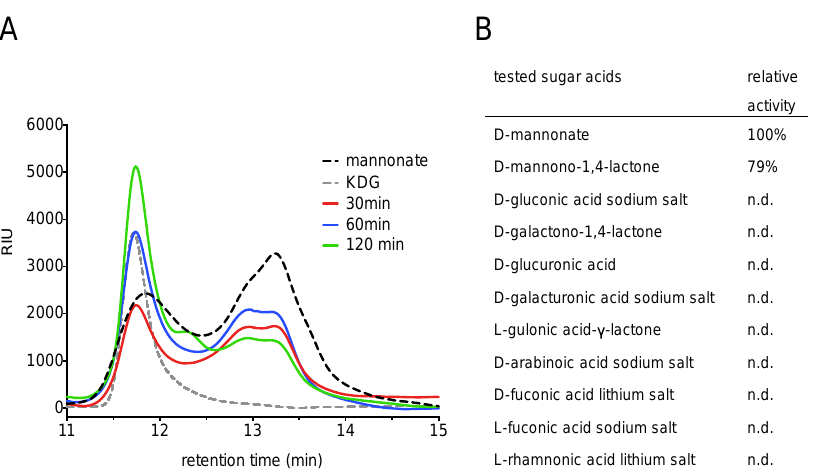
Figure 8. Substrate specificity and product analysis of reactions with TaManD. ( A ) Reactions with TaManD and 10 mM mannonate analysed by HPLC equipped with a refractive index detector. Standards: 10 mM mannonate (dashed black line), 2.5 mM KDG (dashed grey line). Reactions: stopped after 30 min (red line), stopped after 60 min (blue line), stopped after 120 min (green line). RIU: refractive index units. ( B ) List of sugar acids that were tested as substrates for TaManD. Activity is expressed relative (%) to the maximal activity obtained in the assay; n.d.: no signal detected after 16 h of incubation. Lactones except for D-mannono-1,4-lactone were hydrolysed by incubation in 1 M NaOH for 1 h at room temperature and then diluted in 50 mM HEPES pH 7 to obtain free sugar acids. All sugar acids were tested at a concentration of 10 mM in duplicate experiments.